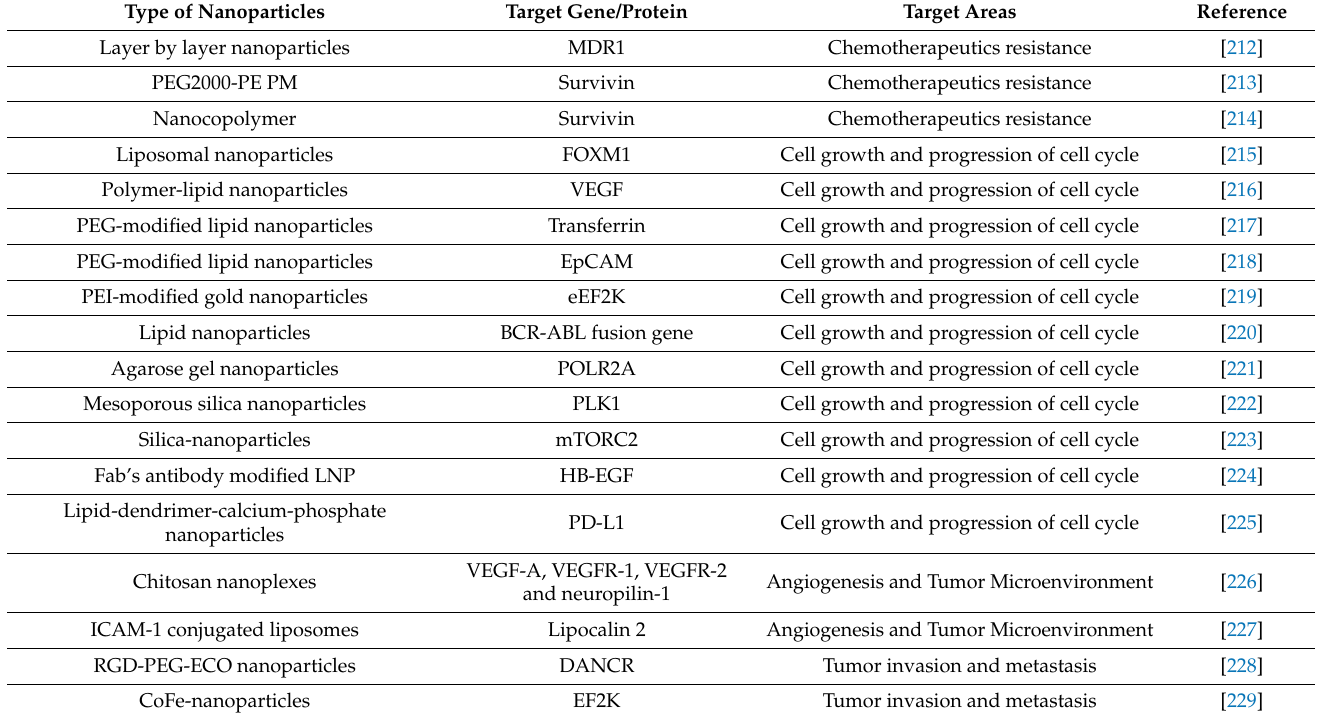
Table 4. A list of preclinical studies using siRNA-based delivery systems for reduction in tumor growth, vascularization, metastasis, and chemotherapeutic